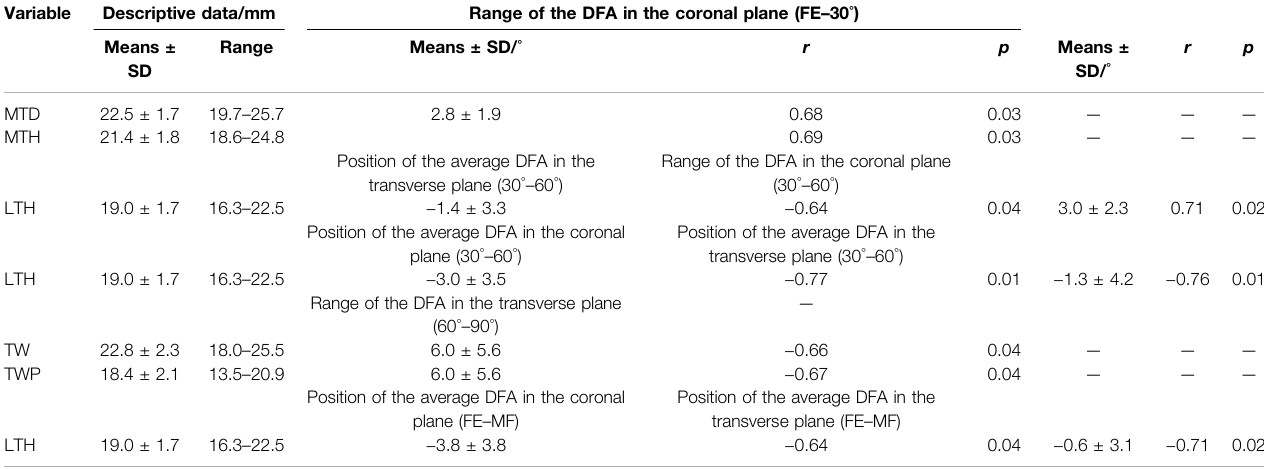
TABLE4| CorrelationbetweenthemorphologicalparameterswiththepositionofaverageDFAandrangeofDFAindifferentphasesof fl exion(FE,fullextension;MF,maximal fl exion). Variable Descriptive